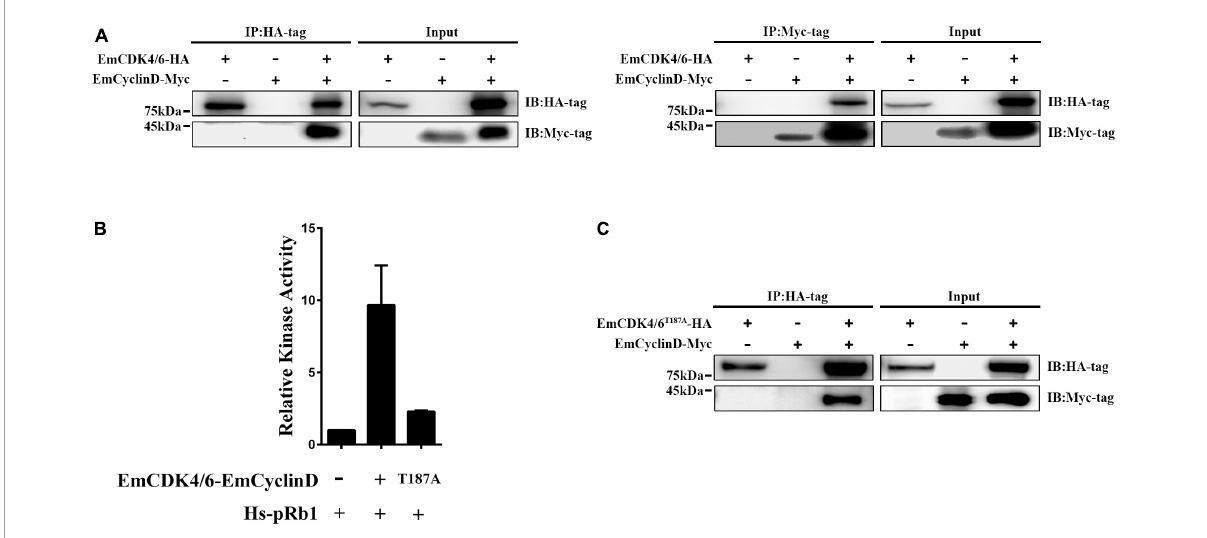
FIGURE2 EmCDK4/6 interacts with EmCyclinD and displays in vitro kinase activity. (A) Co-Immunoprecipitation of HA-tagged EmCDK4/6 with Myc-tagged EmCyclinD. The left shows the results using the anti-HA tag antibody for immunoprecipitation and the right using the anti-Myc tag antibody. (B) In vitro kinase assay of the EmCyclinD-EmCDK4/6 complex or EmCyclinD-EmCDK4/6 T187A complex. Data are shown as mean ± SD of duplicate. (C) Co-Immunoprecipitation of EmCyclinD with EmCDK4/6 T187A mutant. Note that the mutation T187A does not affect the binding of EmCyclinD to